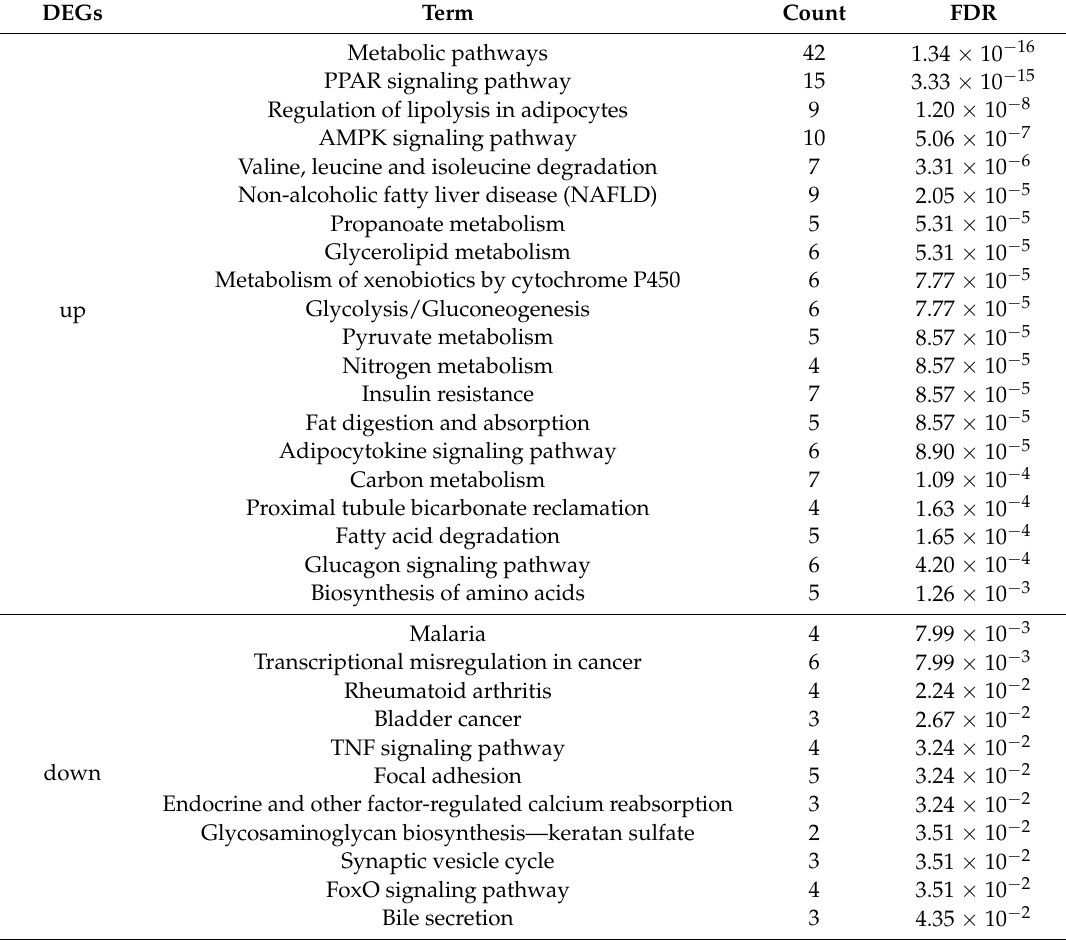
Table 4. Kyoto Encyclopedia of Genes and Genomes (KEGG) pathway enrichment analysis of DEGs in